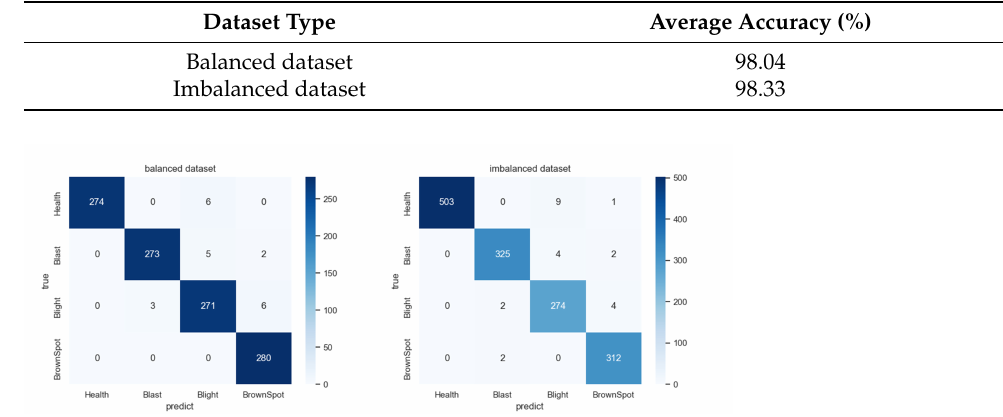
Figure 18. Confusion matrix for the effect of imbalanced test set on ResNet-50 test results.